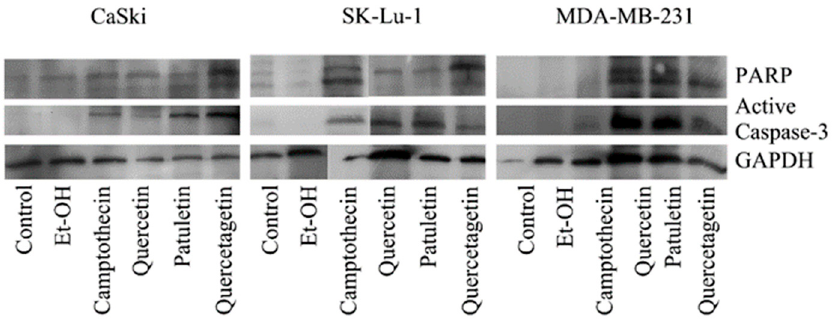
Figure 9. Expression of active caspase-3 and PARP in CaSki, MDA-MB-231 and SK-Lu-1 cell cultures exposed to quercetin, quercetagetin and patuletin at the aforementioned IC 50 values.